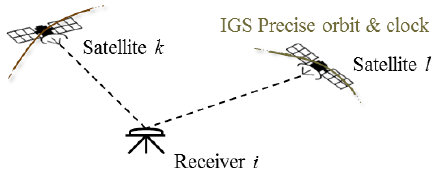
Figure 2. PPP technique (Tseng et al.